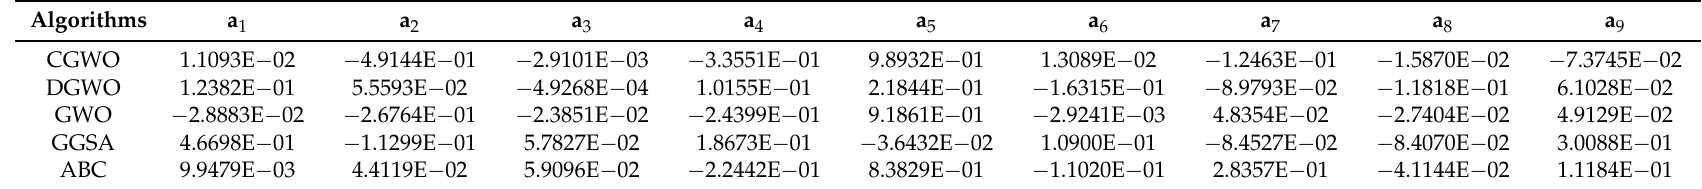
Table 13. The best parameter values (ABP).